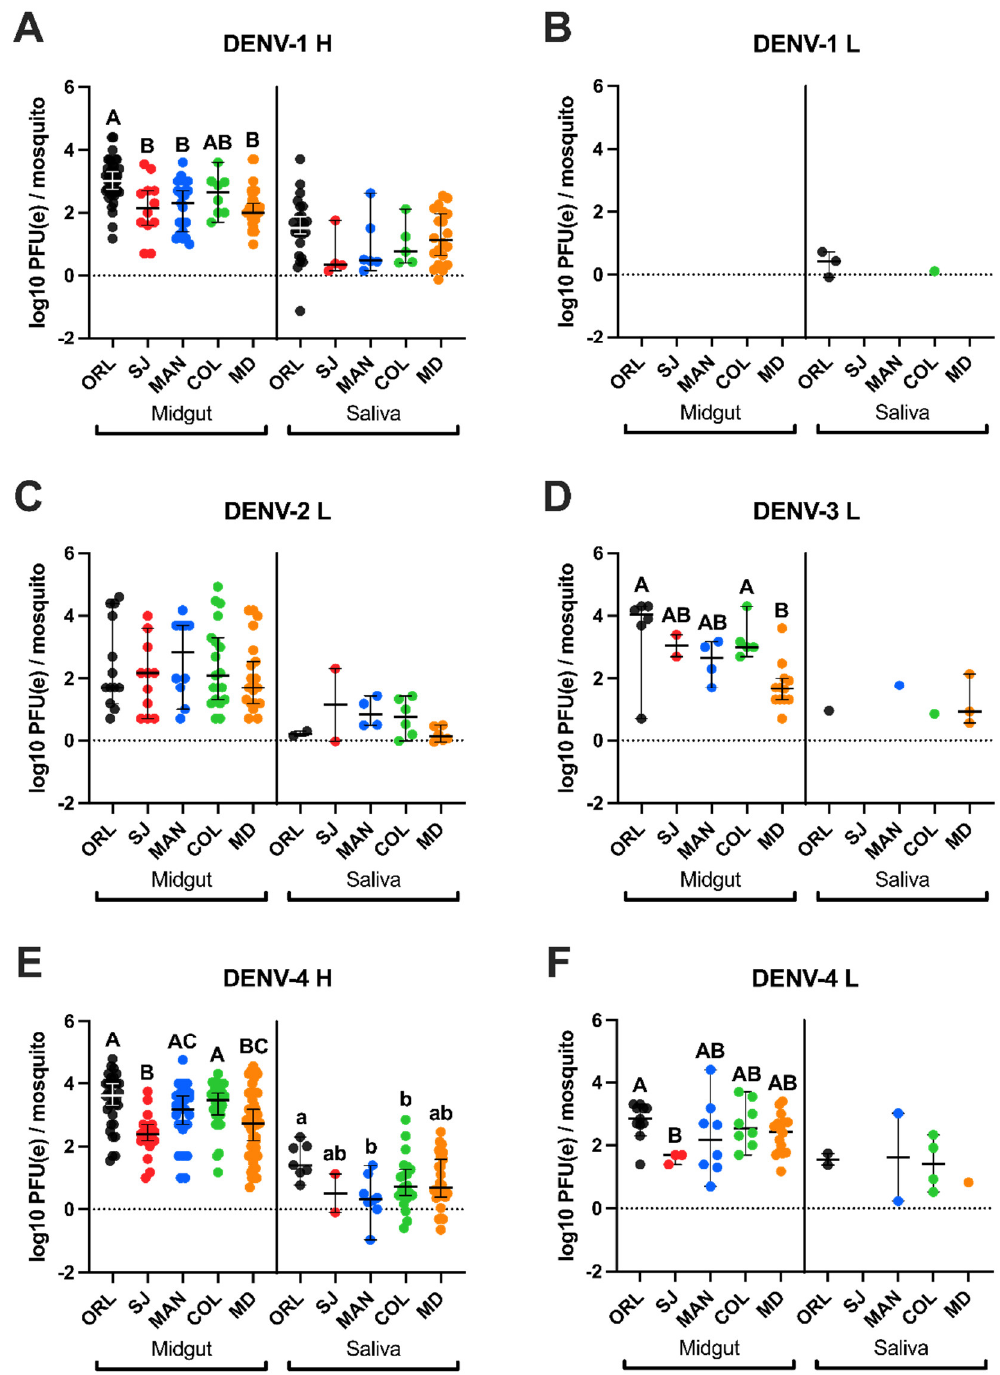
Figure 3. Infection intensities for Floridian Aedes aegypti (exposed to ( A ) DENV-1 Haiti, ( B ) DENV-1 laboratory, ( C ) DENV-2 laboratory, ( D ) DENV-3 laboratory, ( E ) DENV-4 Haiti, ( F ) DENV-4 laboratory) were elevated for low passage DENV strains (DENV-1 H and DENV-4 H) compared to laboratory virus strains. Differences in alphabetical capital letters (A, B, C) denote statistical significance between midgut infection intensities within each virus group. Differences in lowercase letters (a or b) denote statistical significance between saliva infection intensities within each virus group. Groups without any statistically significant differences do not have any alphabetical letter labeling. Significance is measured using an alpha level of 0.05 via mixed methods ANOVA.